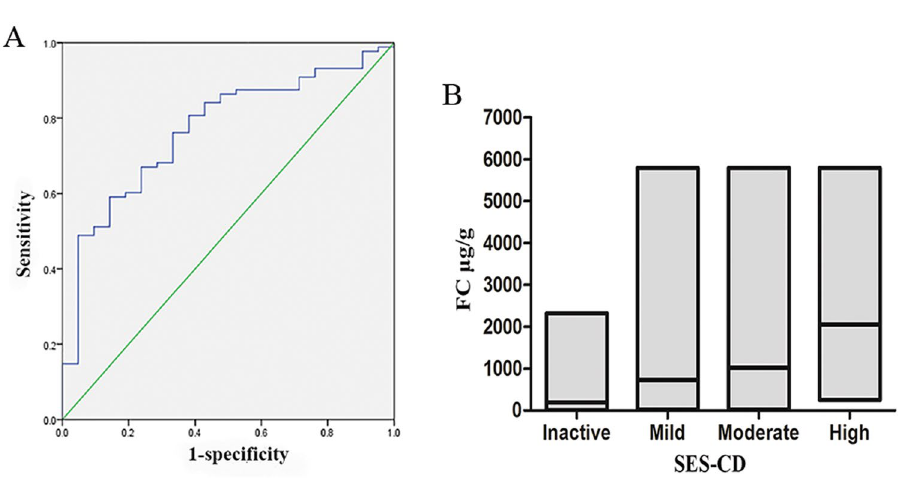
Figure 3. ( A ) Receiver operating characteristic (ROC) curve of faecal calprotectin in predicting endoscopic mucosal healing. The area under the curve was 0.768 (95% CI: 0.664–0.872); ( B ) Faecal calprotectin concentrations in different levels of endoscopic Crohn’s disease activity. The horizontal line in the middle of the box is the median, and the box represents the lower and upper